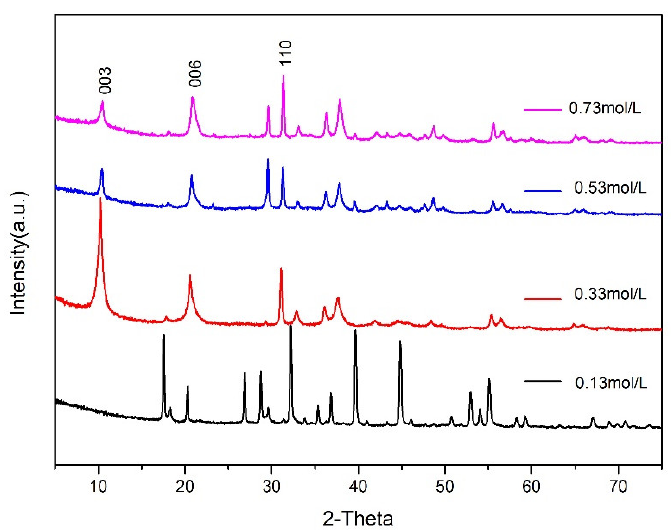
Figure 10. XRD patterns of CaAl–SiO 3 –LDHs prepared at different Ca 2+ molar